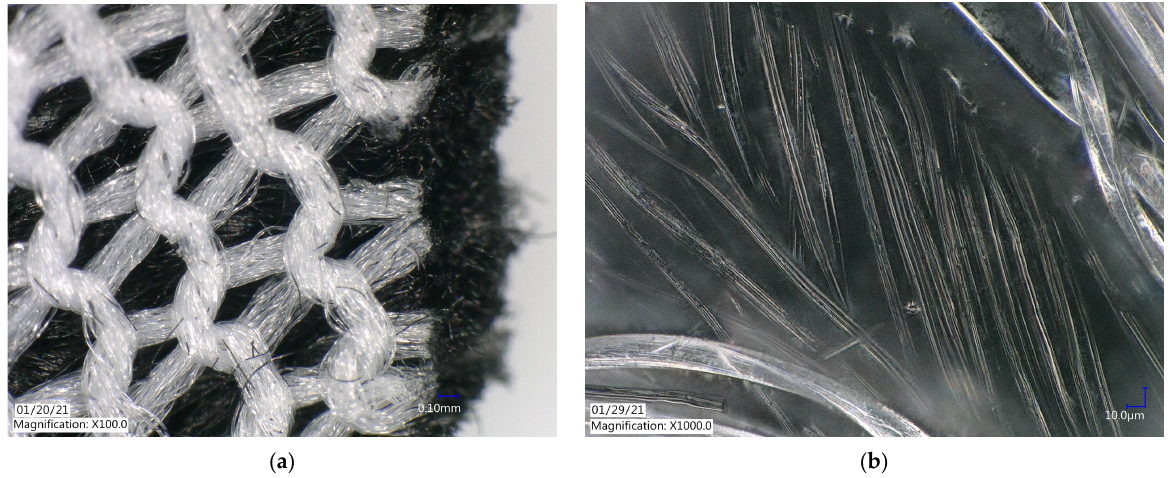
Figure 2. ACL under Keyence VHX-6000 digital microscope at ( a ) ×100 magnification and ( b ) ×1000 magnification.